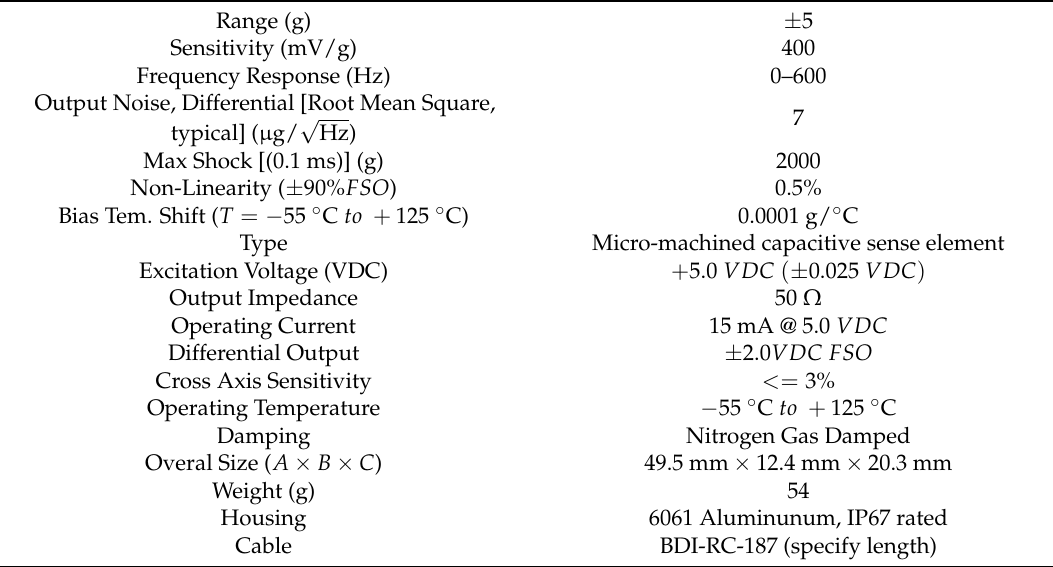
Table 3. Specifications of wireless